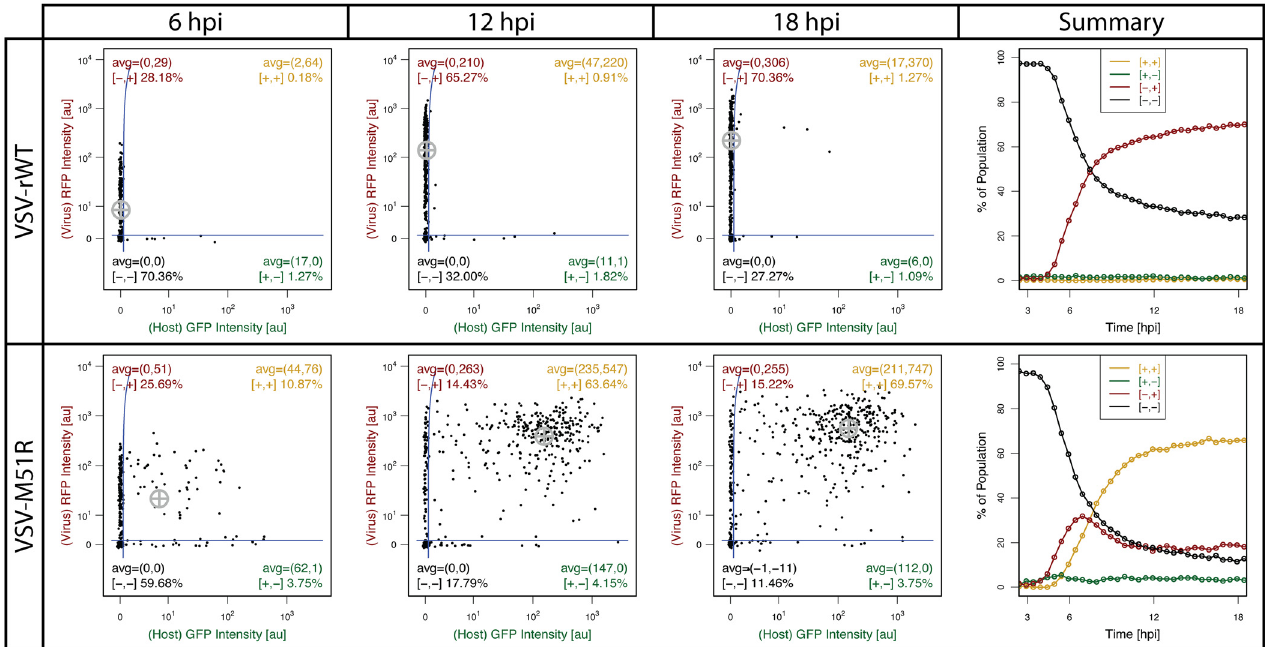
Fig 7. Microwell-array-based cytometry plots (VSV-M51R & VSV-rWT) show agreement with results from baseline cytometry experiments from Fig 6.